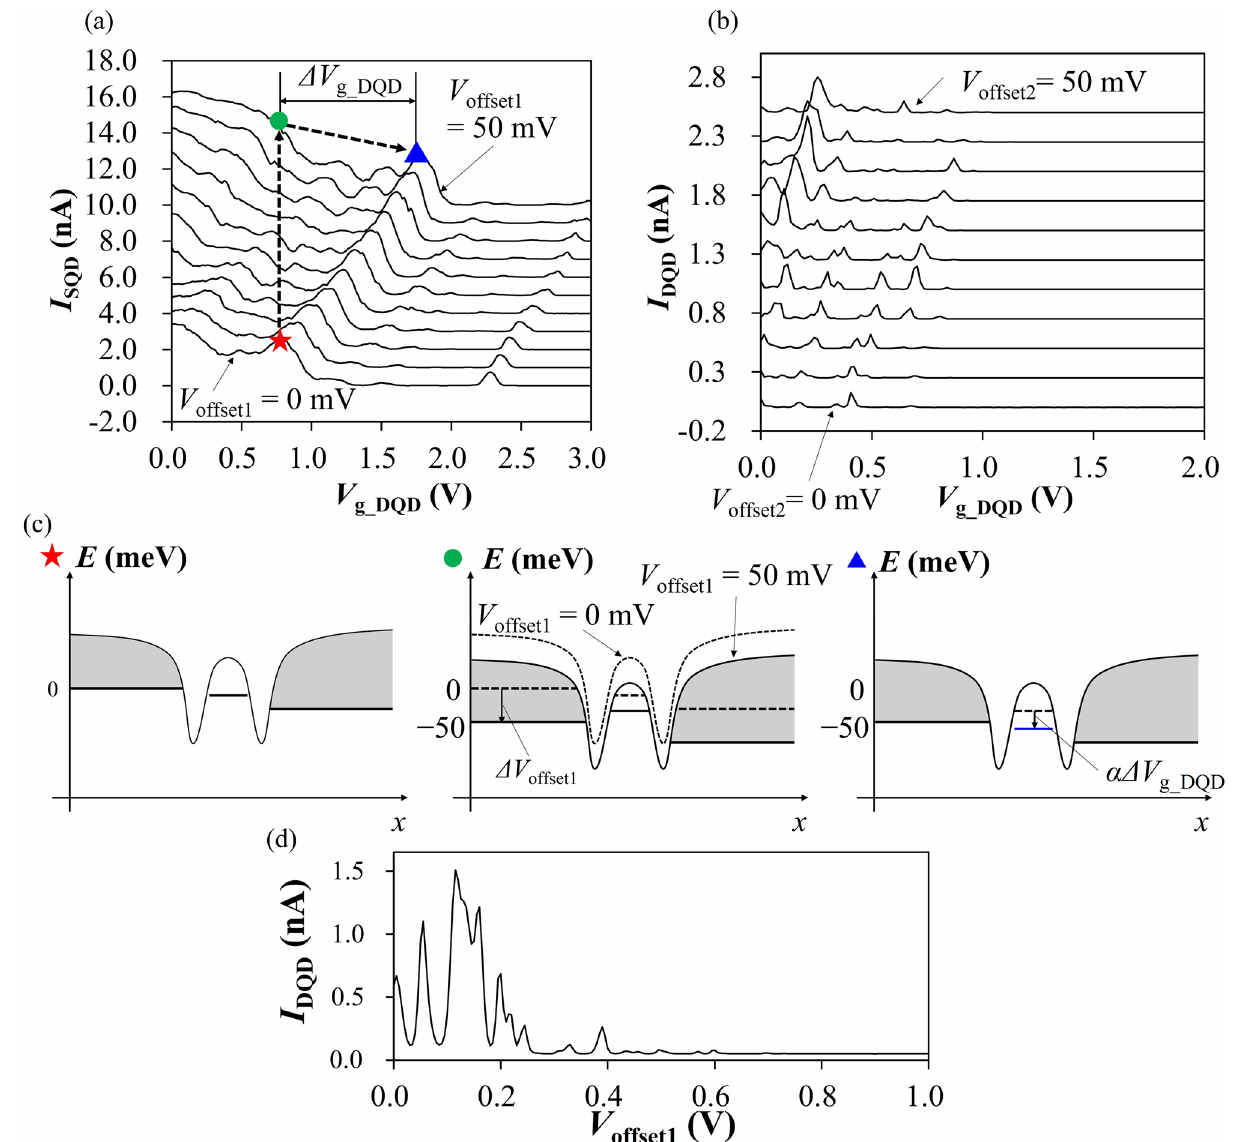
Figure 4. Measurement results. ( a , b ) Measured current through ( a ) SQD (( b ) DQD) as a function of V g_DQD at different reservoir offset voltages, V offset1 ( V offset2 ) between 0 mV (bottom) and 50 mV (top). V TG = − 1.7 V, V bias1 = 4 mV in ( a ), V bias2 = 1 mV in ( b ) at a temperature of 4.2 K. Each trace is given an offset of 1.0 nA in ( a ) and 0.25 nA in (b) for clarity, respectively. The DQD current in ( b ) shows an SQD-like behavior because two QDs of the DQD are strongly coupled to each other. These position shifts correspond to potential modulation in the QD generated by the reservoir offset voltage as shown in the diagrams in ( c ). ( c ) Energy diagrams for red- star (left), green-circle (center) and blue-triangle (right) conditions in ( a ), respectively. x axis indicates the lateral position of channel including QD. ( d ) Current through the DQD as a function of V offset1 applied to the SQD. V TG = − 1.7 V and V bias1 = 1.0 mV are fixed in this